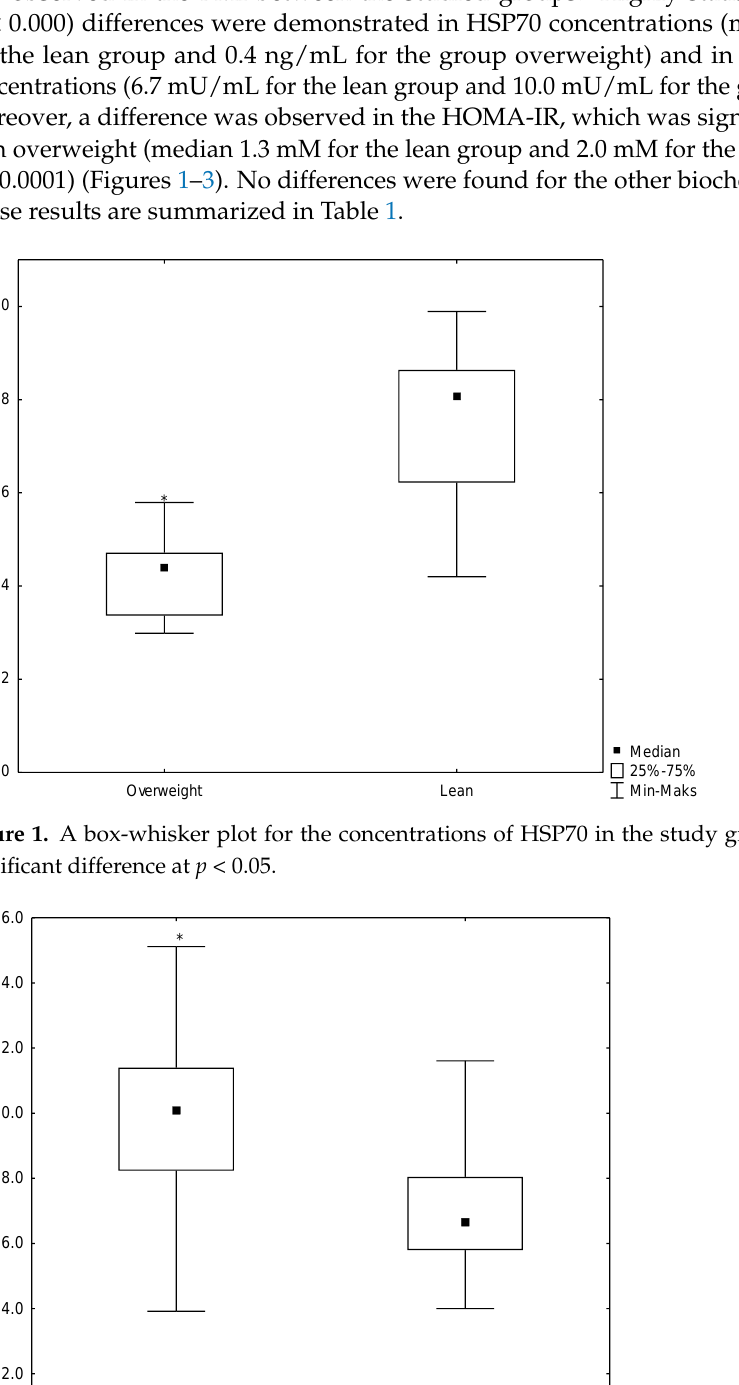
Figure 3. Box-whisker plot for HOMA-IR values in the study groups. * statistically significant dif- ference at p < 0.05.